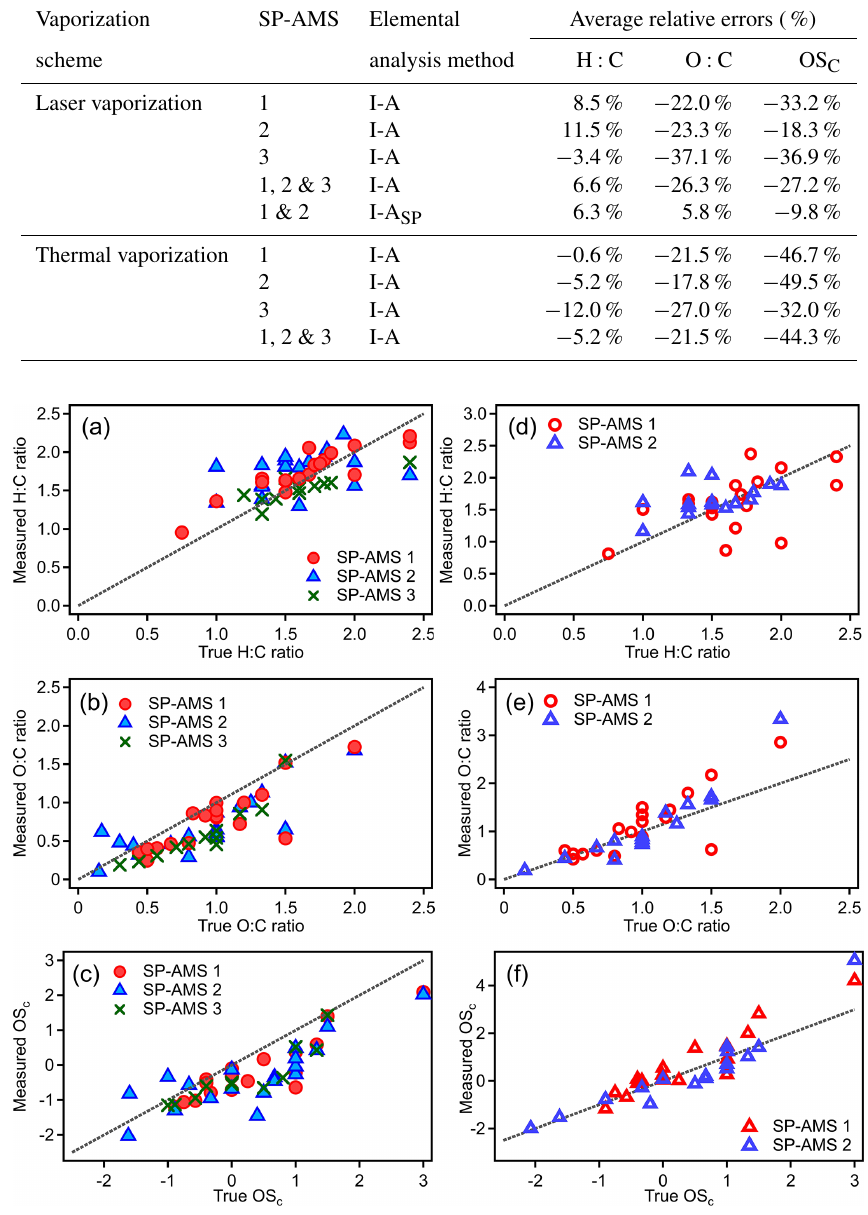
Figure 4. Comparisons between the measured and true values of H : C, O : C, and OS C determined using the three SP-AMSs using the LV scheme. Panels (a–c) and (d–f) show the results calculated using the I-A method and I-A SP method, respectively. Red circles, blue triangles, and green crosses represent data measured by SP-AMS 1, 2, and 3, respectively. The dashed lines represent 1 : 1